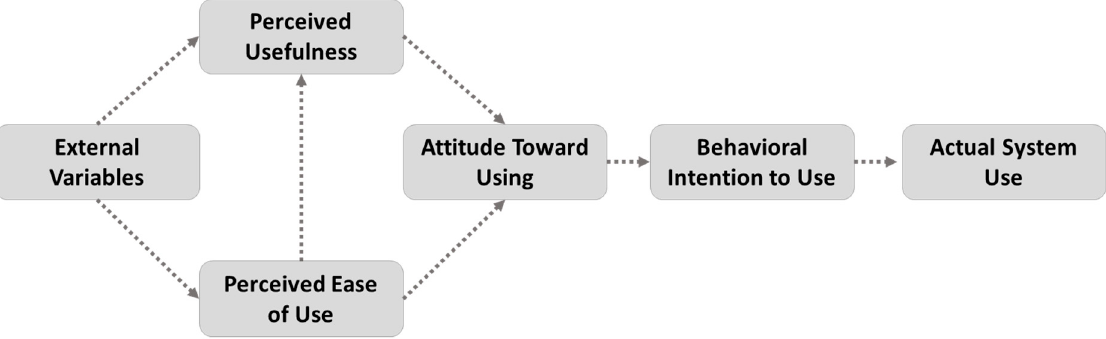
Figure 2. Technology acceptance model (TAM) dimensions.